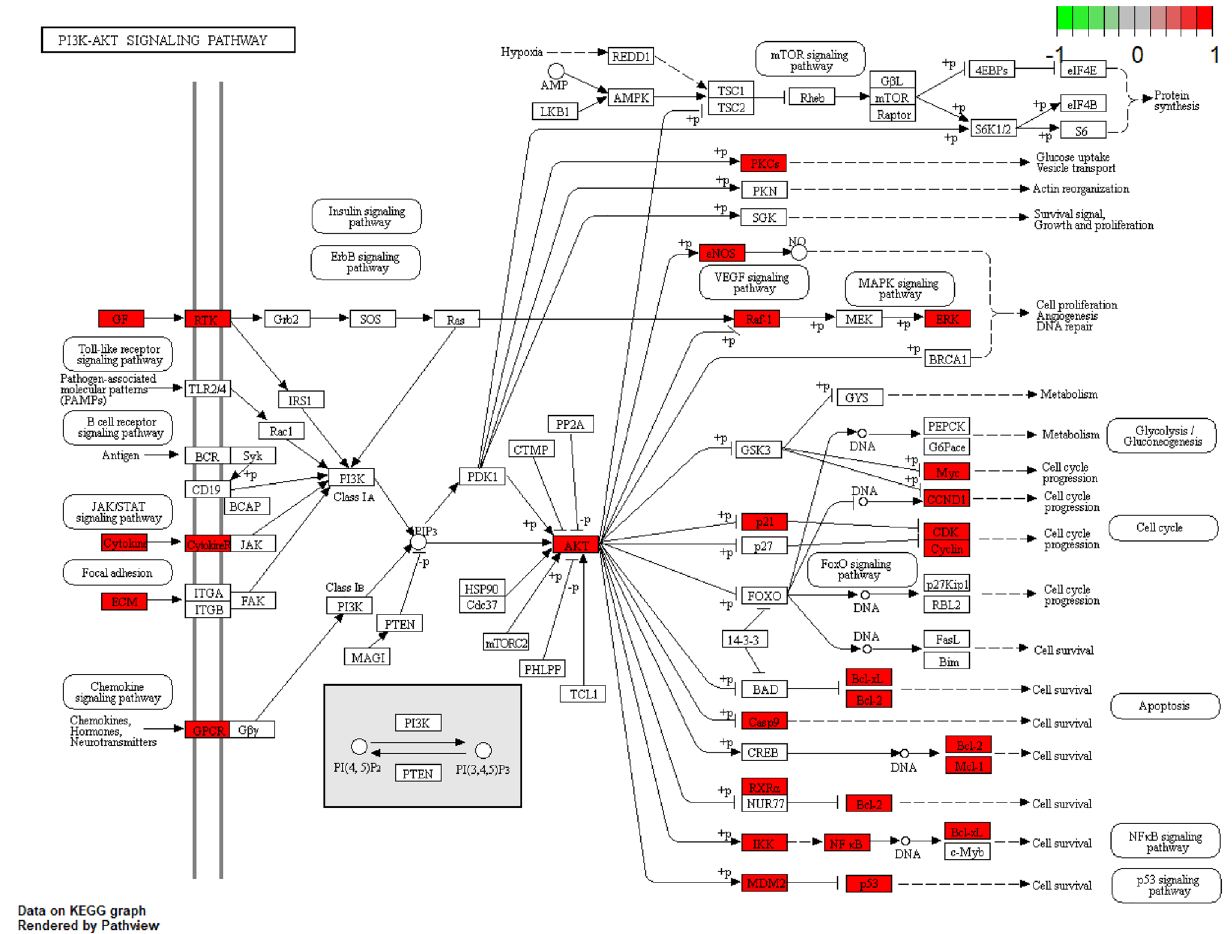
Figure 3. Pathway maps of potential targets for KEGG analysis. The red part represents the targets of WLZYW.